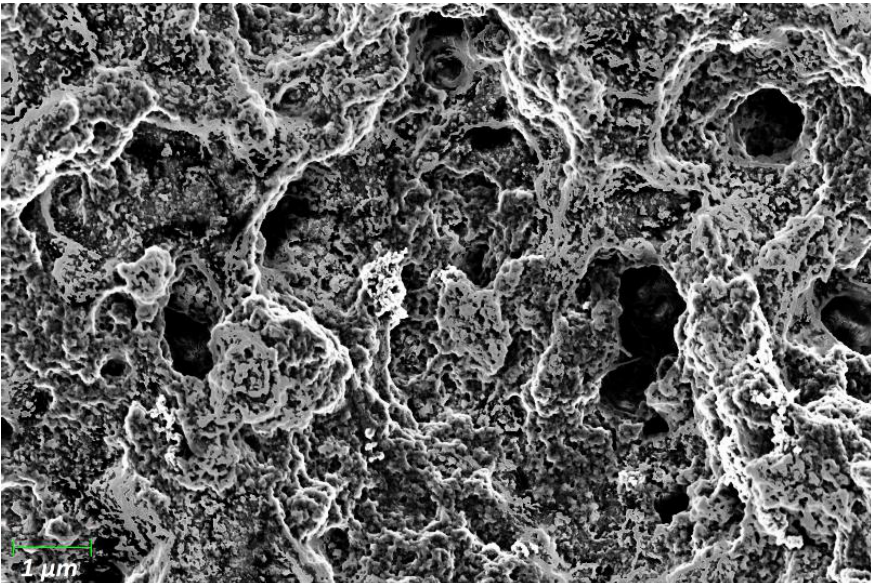
Figure 2. Scanning an electron microscope image of a polyaniline film doped with 2 wt% carbon black.